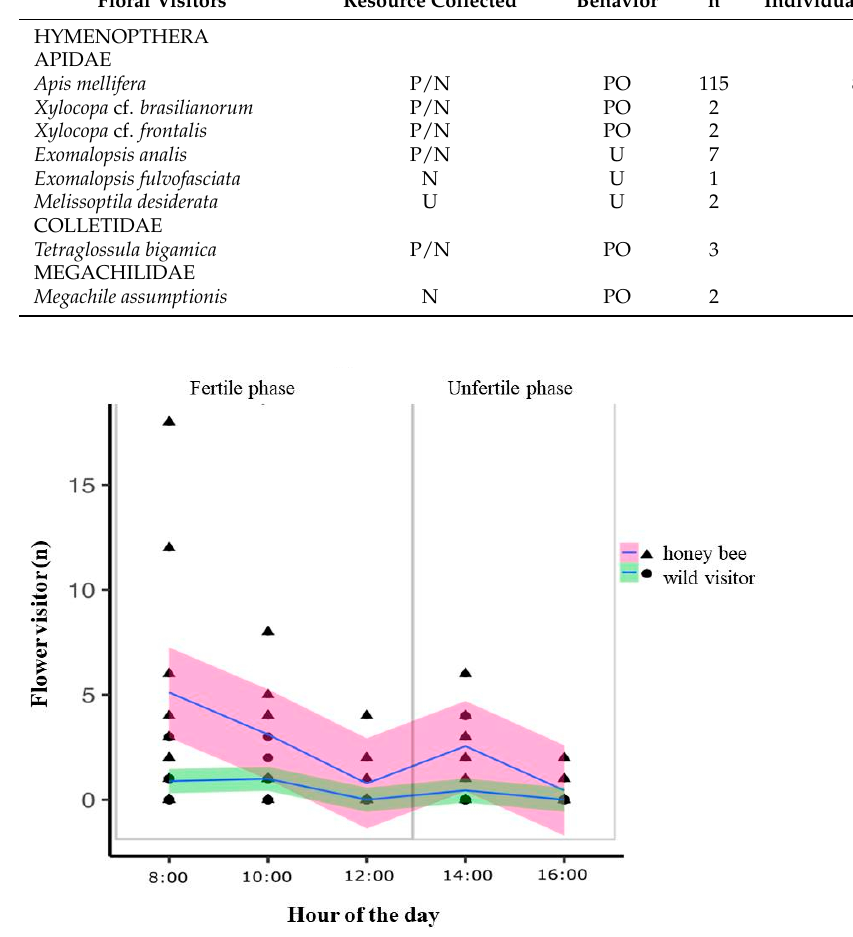
Figure 4. The number of honey bees visiting the flowers were significantly higher compared to all other wild native visitors together. The abundance of individuals varied significantly a long the day. Floral visits occurred mainly during the fertile phase of L. nervosa . Table 1. Type of resource collected, behavior and percentage of floral visitors of Ludwigia nervosa . Captions: P—pollen, N—nectar, U—undefined, and PO—pollinator.